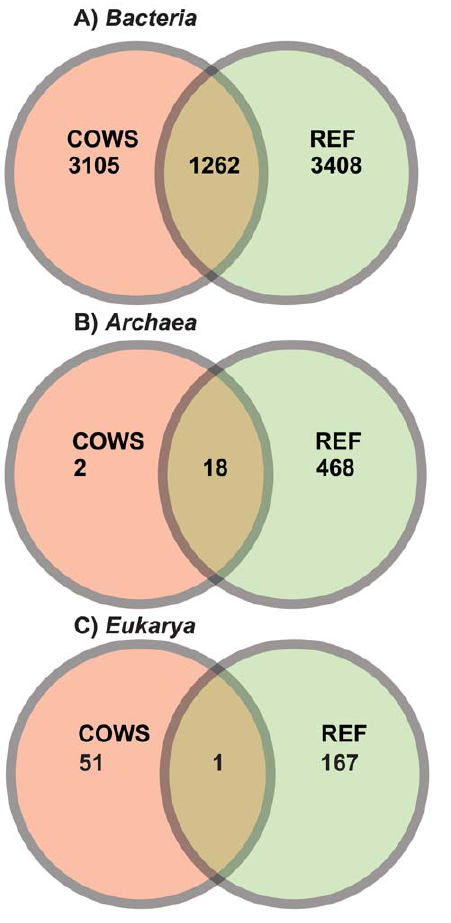
Figure 1. Comparison of rumen SSU microbial sequences to data in public repositories. The Venn diagram depicts OTUs that were unique to the 12 cows used in this study (COWS), unique to the public repositories (REF) or